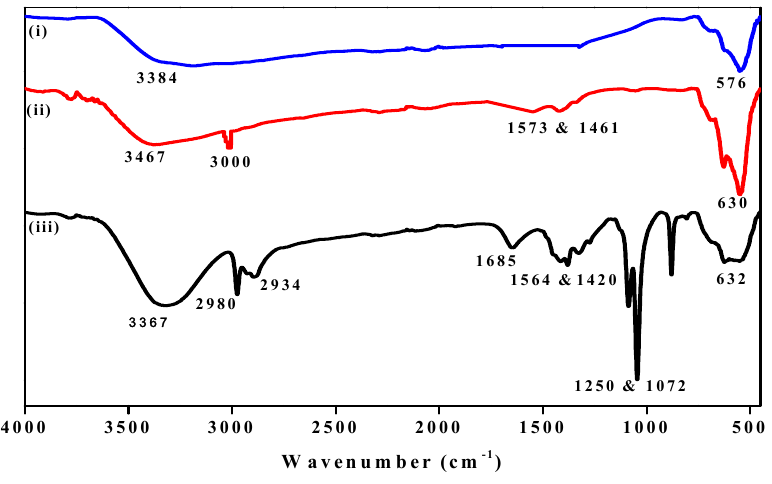
Figure 2. FTIR of: ( i ) MNP; ( ii ) MNP@PTh; ( iii ) MNP@P3TArH.